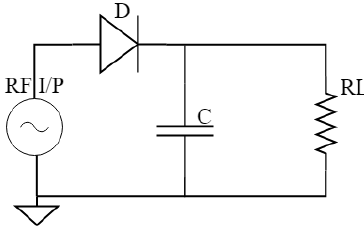
Figure 2. Block diagram of the wireless energy harvesting system.